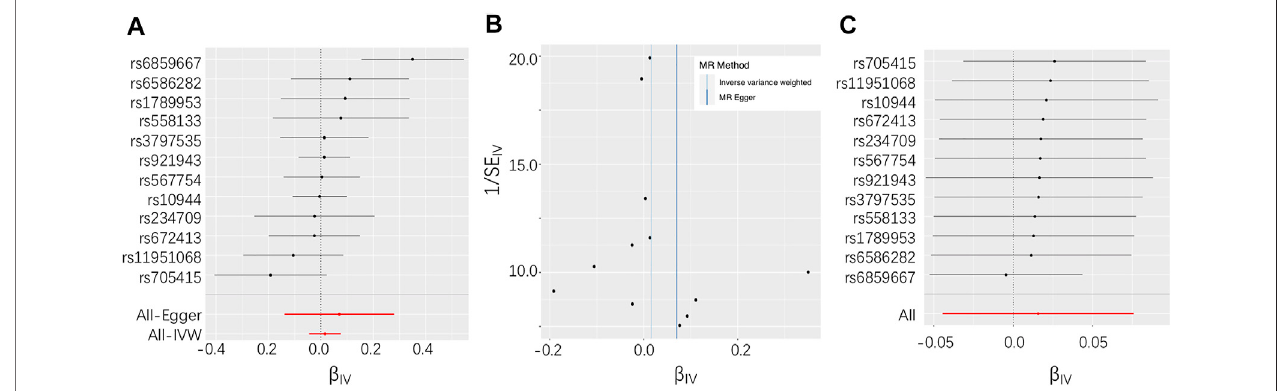
FIGURE 1 | (A) Forest plot for individual causal effect estimate based on the set of 12 instruments. (B) Funnel plot displaying individual causal effect estimates for selenium on amyotrophic lateral sclerosis (ALS). (C) Leave-one-out (LOO) results of selenium on ALS.